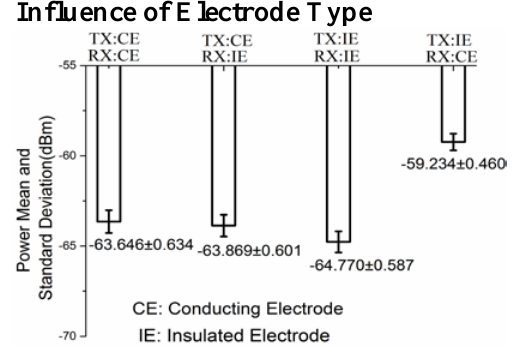
Figure 8. The influence of electrode